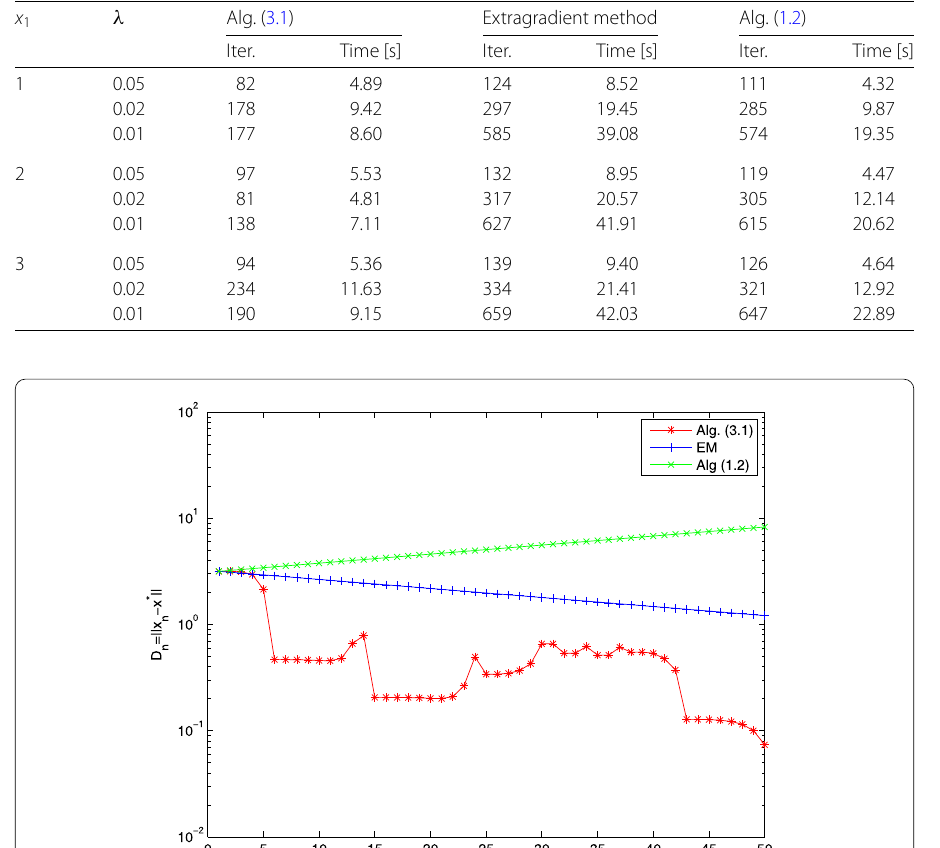
Table 1 Numerical results as regards Example 1